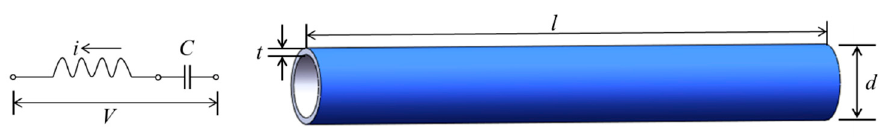
Figure 2. The unit cell of hollow steel tube (HT) structure.